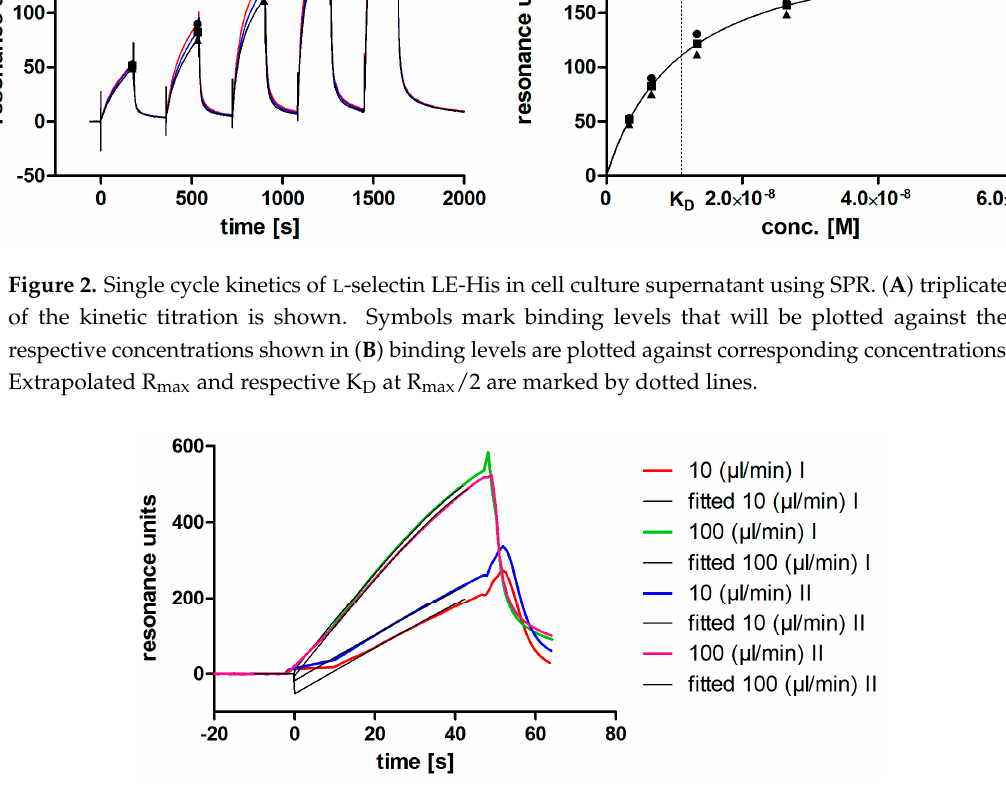
Figure 3. Calibration free concentration analysis using SPR. L-selectin LE-His in cell culture supernatant was analyzed in duplicate. The sensorgrams (colored lines) and the fits (black lines) at the different flowrates are shown. Table 2. Affinity matrix performance. ( a ) amount of L-sel LE-His from cell culture supernatant bound